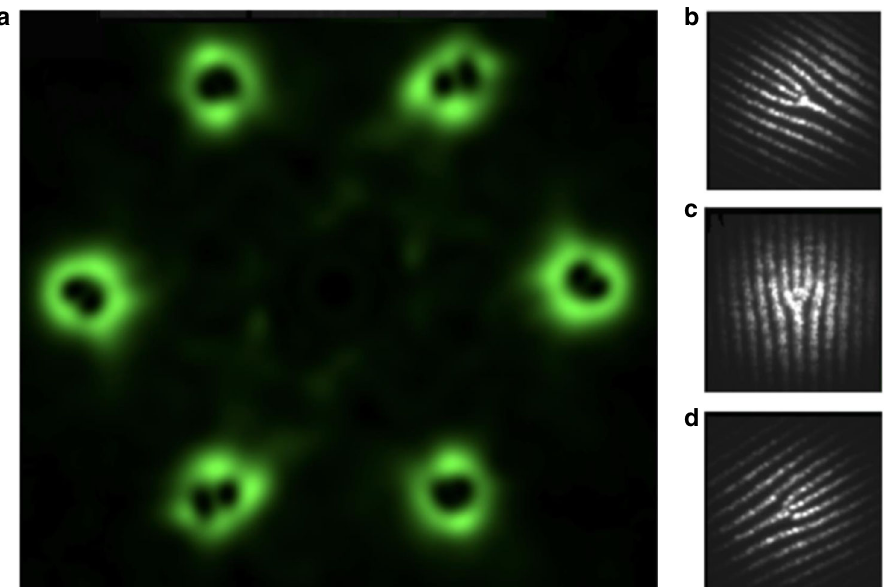
Fig. 4 Theoretical modeling of the second harmonic generation from 3D nonlinear photonic crystal. a Calculated far- fi eld second harmonic intensity distribution emitted from the three-layer fork nonlinearity pattern illuminated by Gaussian fundamental beam at 1000 nm. b – d The χ (2) patterns used in the calculations